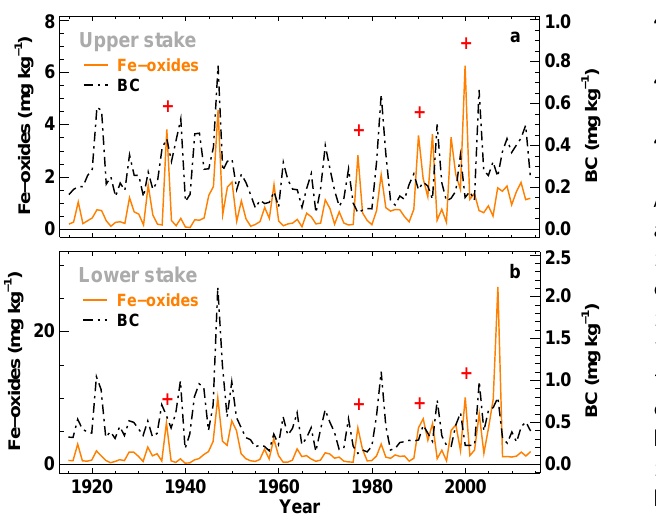
Figure 4. Average Fe-oxide and BC concentrations in the surface snow at the upper and lower measurement site on Claridenfirn for the period 1914–2014. The crosses mark years with exceptionally high Saharan dust activity. Note that the scales for upper and lower stake are